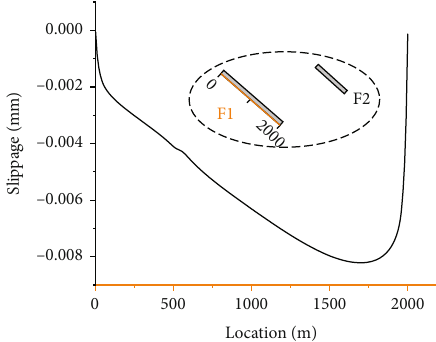
Figure 23: The fault slippage of F1 when the hydraulic fracturing region is